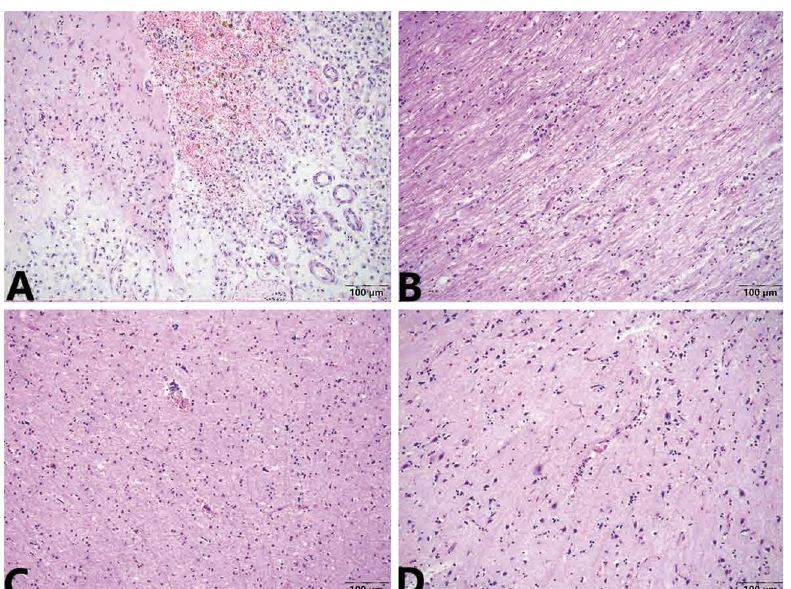
Figure 2. Microscopic change of brain of Case 1. ( A ) The lesions of hyperemia and haemorrhage, liquefactive necrosis, a massive collection of foam cells, and haemosiderosis are presented in the meninges and cerebral cortex. ( B ) Demyelination reactions are visible in white matter. ( C ) Bleeding foci scattered in cortex. ( D ) Capillary hyperemia; edema; moderate vascular cuff reaction (lymphohistiocytic perivascular infiltrates), neuron necrosis and neuronophagia are also visible in the brain parenchyma. Stained using haematoxylin and eosin (H&E). Captured by Olympus CX 43 microscope and EPview Ver 1.2.